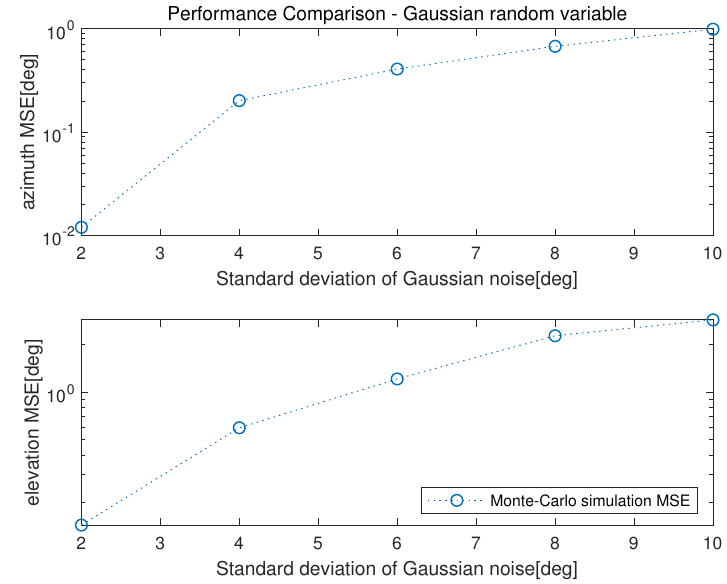
Figure 9. Performance for Gaussian − distributed phase measurement error with θ ( 0 ) = 120 ◦ and ψ ( 0 ) = 45 ◦ . This figure shows the MSEs of azimuth and elevation with respect to phase error at a signal with low incident elevation by monte-carlo simulation(rectangular plannar array).